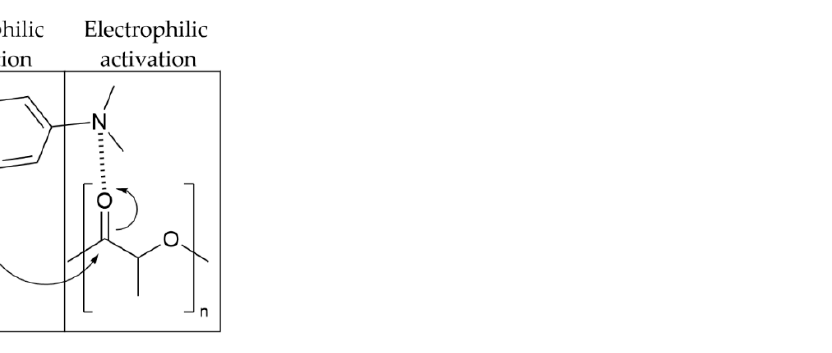
Figure 5. DMAP coordination to methanol and a PLA ester group during methanolysis.